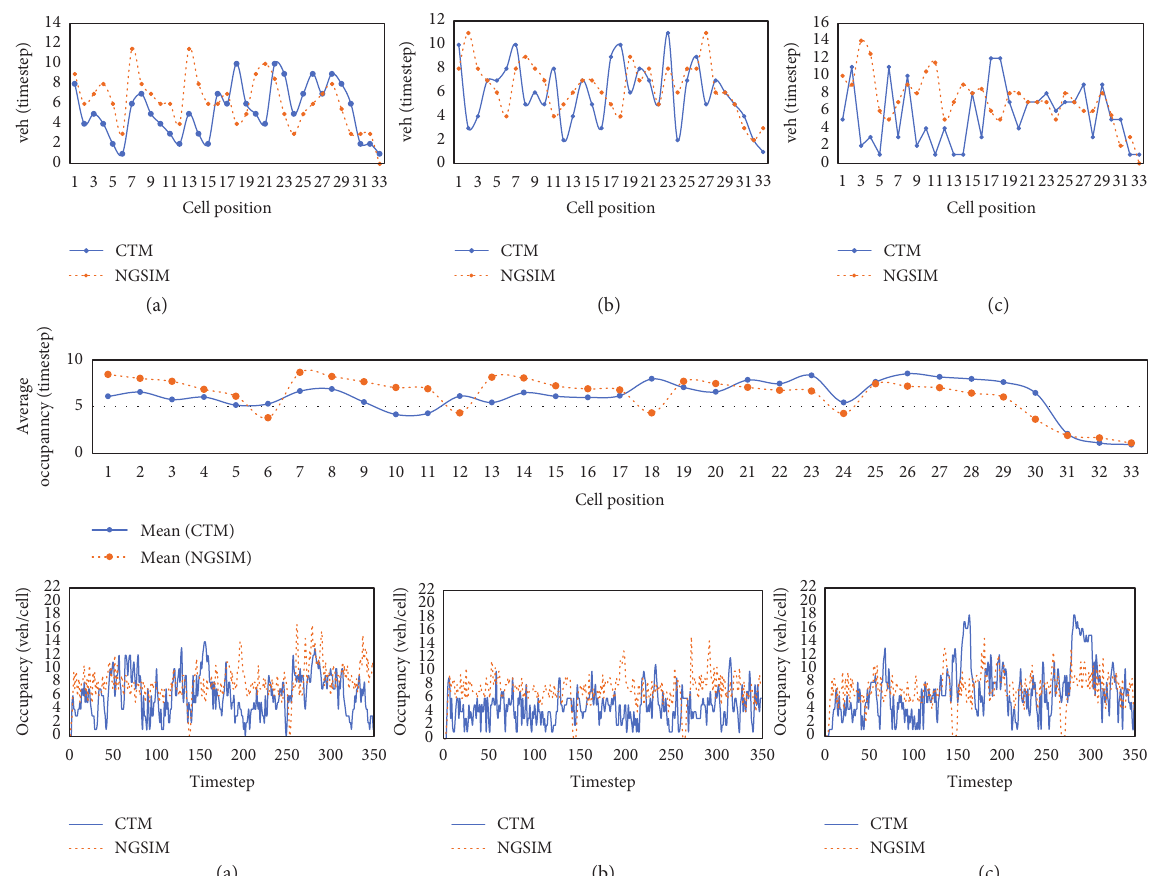
Figure 15: Validation of CTM with US-101 for case 1. (a) 50 th , (b) 100 th , and (c) 200 th time step of all